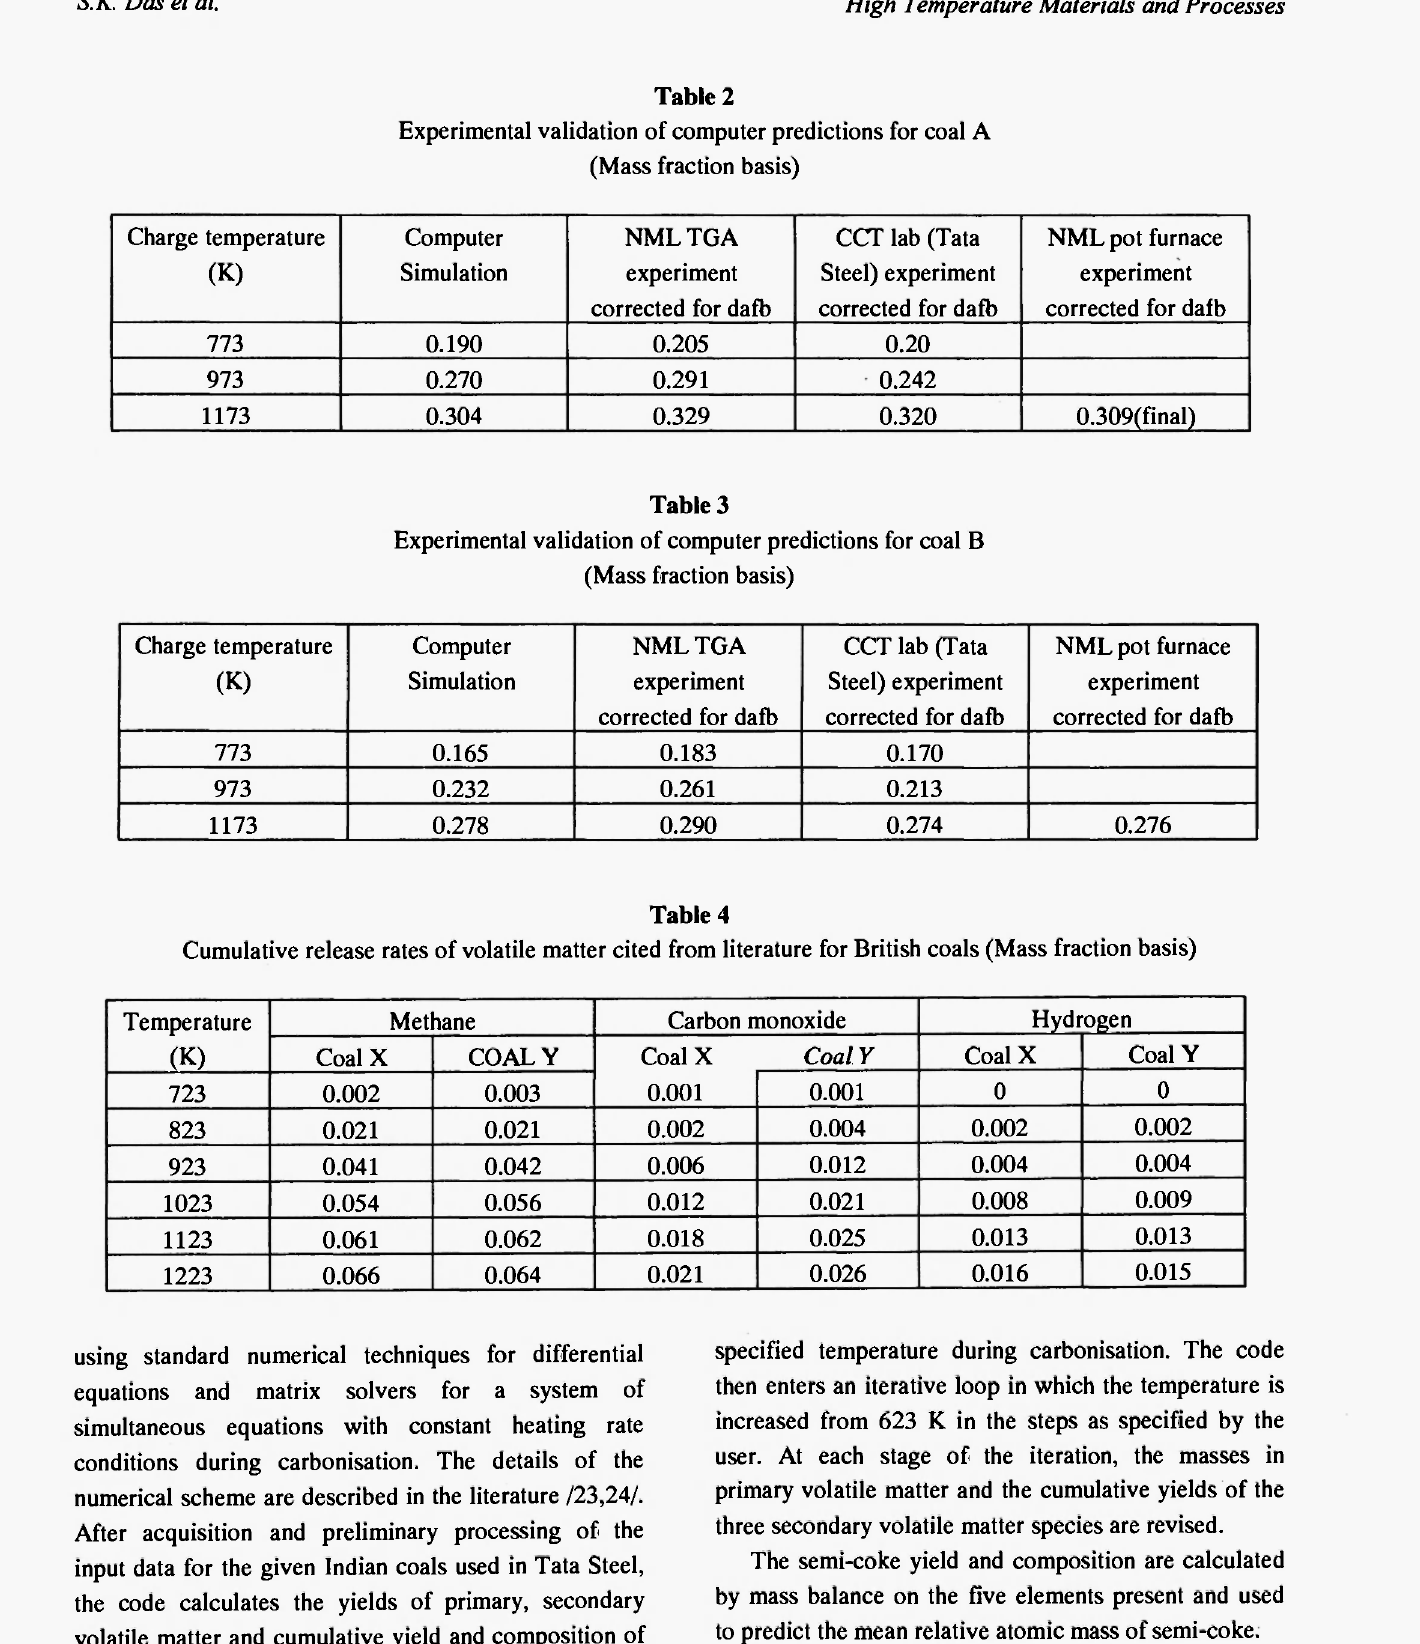
Experimental validation of computer predictions for coal A